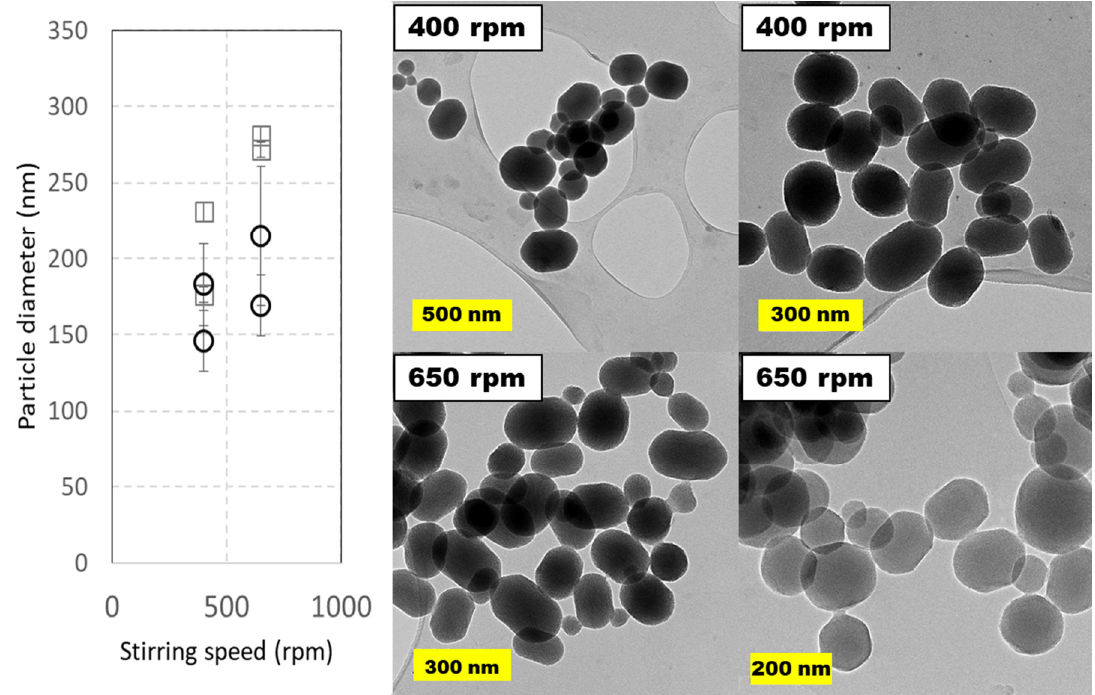
Figure 6. Particle size distributions and TEM images of MCM-41 MSNs prepared in pilot-plant scale under different stirring speeds (400 and 650 rpm). Squares ( ) are used for hydrodynamic diameters measured by DLS values and circles ( ) for diameters measured on TEM micrographs. Experimental conditions: 5 L jacketed cylindrical reactor with 4 L working volume with a Rushton turbine as overhead stirrer. Reactions were carried out at 60 °C using TEOS (40 mL, 4 mL·min -1 ) and CTAB (8 g, 2 g ⋅ L -1 ) during 60 min. Data shown correspond to samples 345.2, 345.4, 389.1 and 349.2 in Table S1, Supplementary Materials.